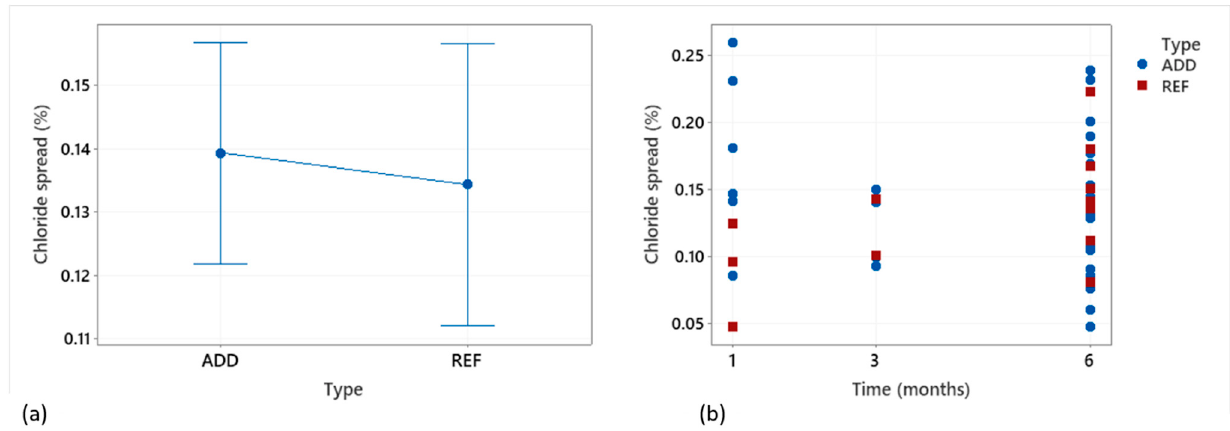
Figure 16. ( a ) Mean chloride surface ingress (spread) through the healed crack for REF and ADD series and ( b ) observed individual values at different time intervals. Results are based on samples that reported 100% sealing efficiency, namely complete crack sealing as assessed by water flow tests.